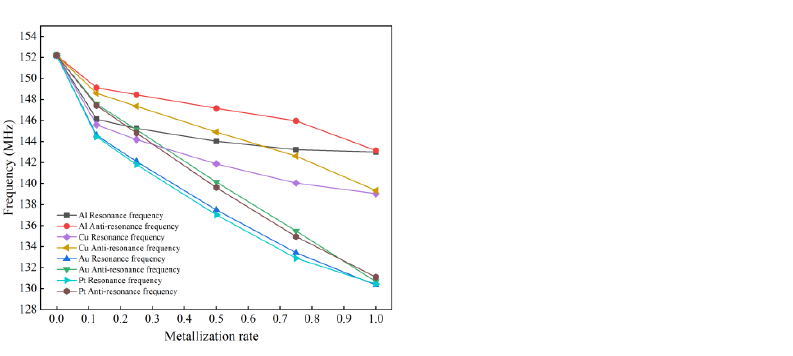
Figure 6. Variation characteristics of metallization rate ‐ frequency under different electrode materi ‐